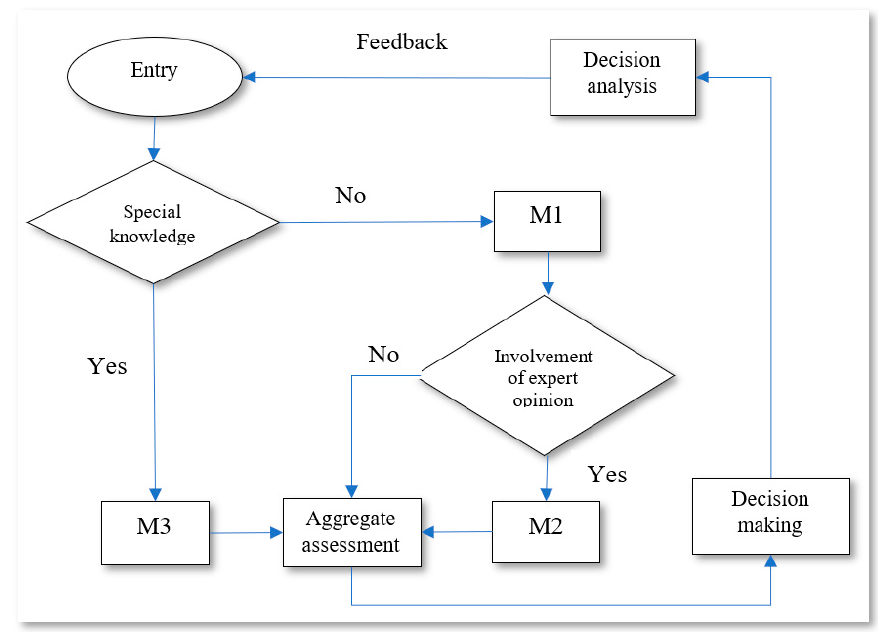
Figure 2. Block diagram of the technology for the assessment and selection of specialists of the smart city: (cid:1839) (cid:2869) —fuzzy model for assessment of competence of specialists; (cid:1839) (cid:2870) —hybrid fuzzy model; (cid:1839) (cid:2871) — smart city: M 1 —fuzzy model for assessment of competence of specialists; M 2 —hybrid fuzzy model; neuro-fuzzy network. M 3 —neuro-fuzzy